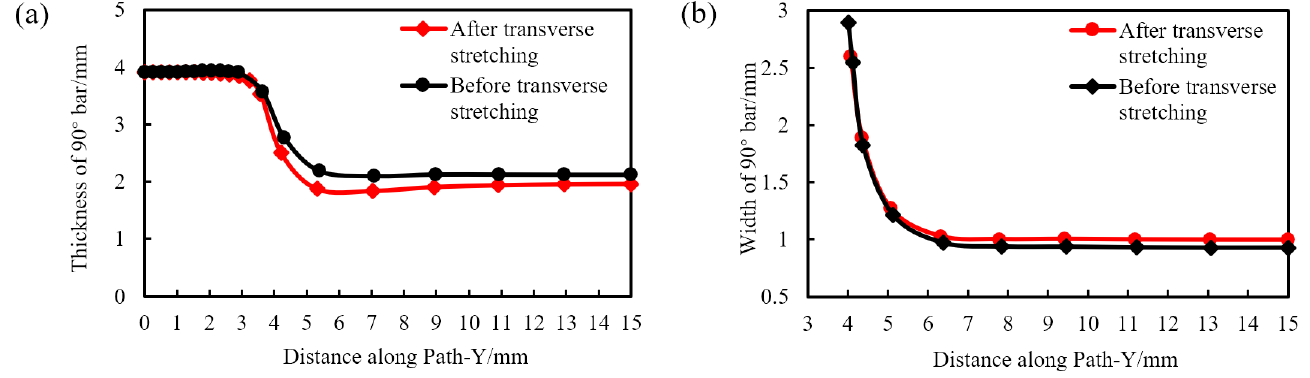
Figure 17. Thickness and width of the 90° rib before and after transverse stretching. ( a ) Thickness, ( b )